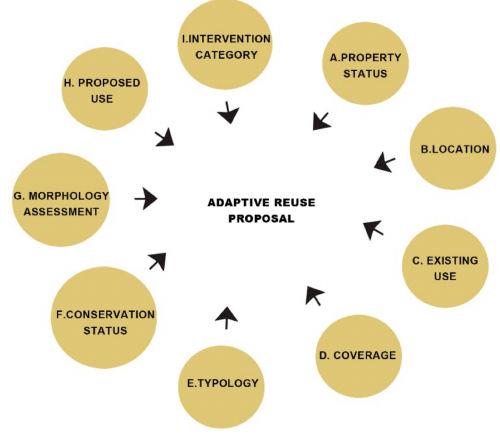
Figure 25. Factors of the